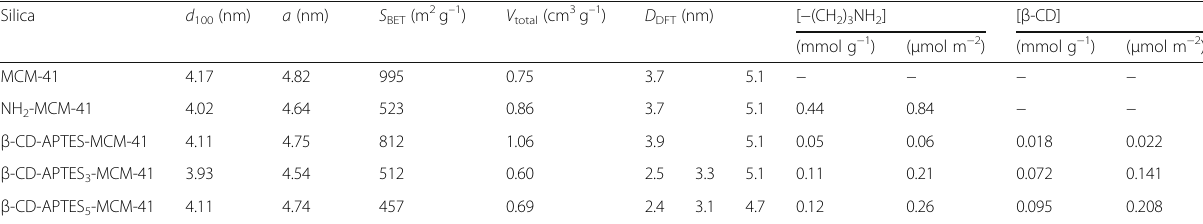
Table 1 Structural properties of MCM-41 silicas